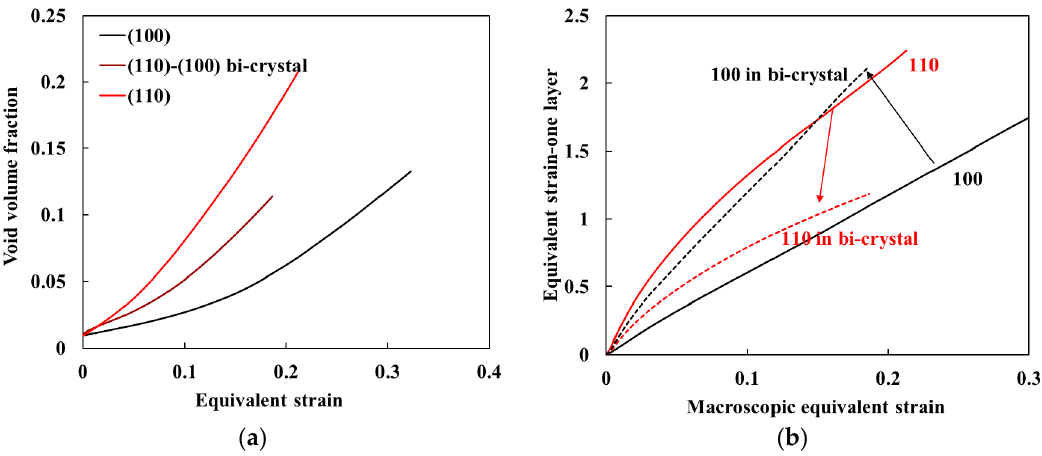
Figure 9. ( a ) evolutions of void volume fractions of (100), (110) single crystals and (100)-(110) bi-crystal as a function of macroscopic RVE strain; ( b ) average strains of one layer elements surrounding voids as a function of macroscopic RVE strain. Solid lines represent the strains for single crystals, while dotted lines are those in the bi-crystal.